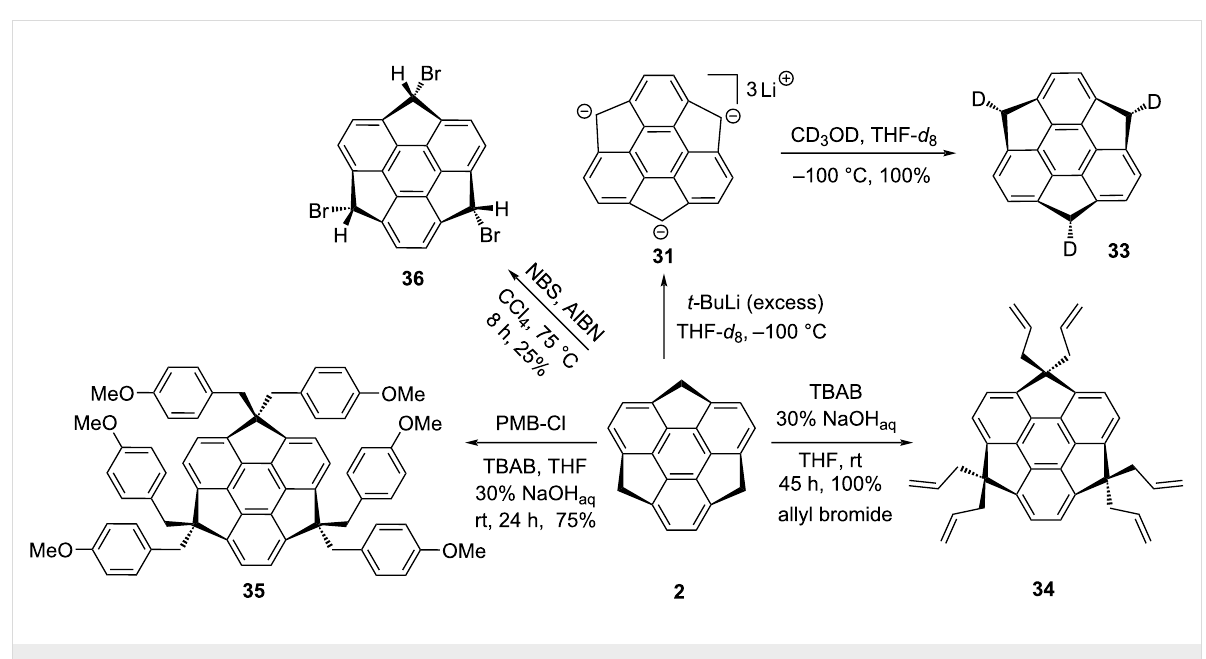
Scheme 5: Synthesis of tri- and hexa-substituted sumanene